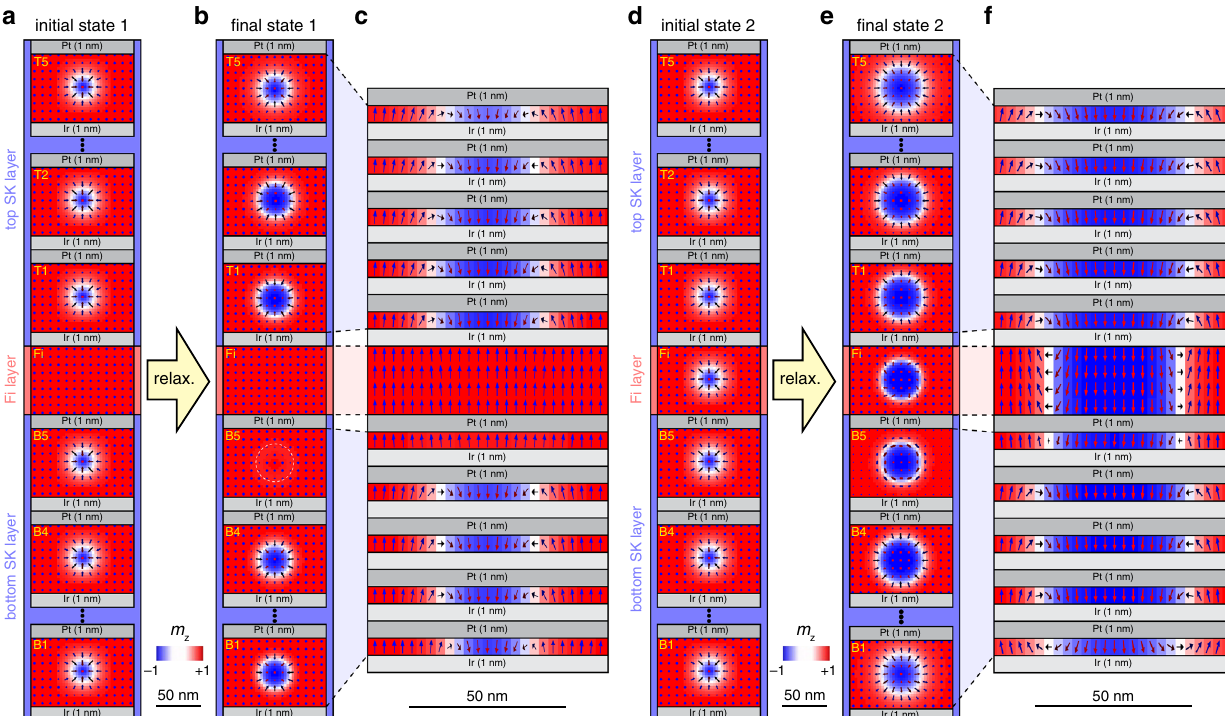
Fig. 3 Micromagnetic simulations for the incomplete and tubular slyrmion phases. a Intial state 1 with a clockwise skyrmion spin texture imposed in the bottom and top skyrmion (SK) layers but not in the ferrimagnetic (Fi) layer. b, c Final state 1 and its corresponding cross-section after relaxation of the initial state 1. A skyrmion spin texture exists solely in the sublayers B1 to B4 of the bottom SK layer and in all sublayers of the top SK layer, but not in the Fi layer. d Initial state 2 with a skyrmion spin texture enforced in all layers. e , f Final state 2 and its corresponding cross-section: a tubular skyrmion running through all layers is stabilized. The colors refer to the z-component of the normalized magnetization (blue-negative and